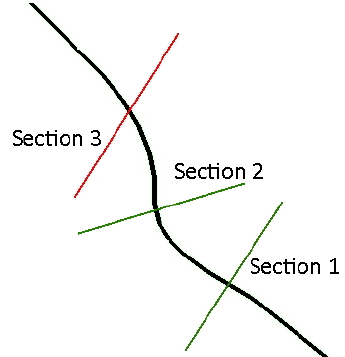
Figure 23. Rejection of a cross-section because it is not perpendicular to the stream’s path.